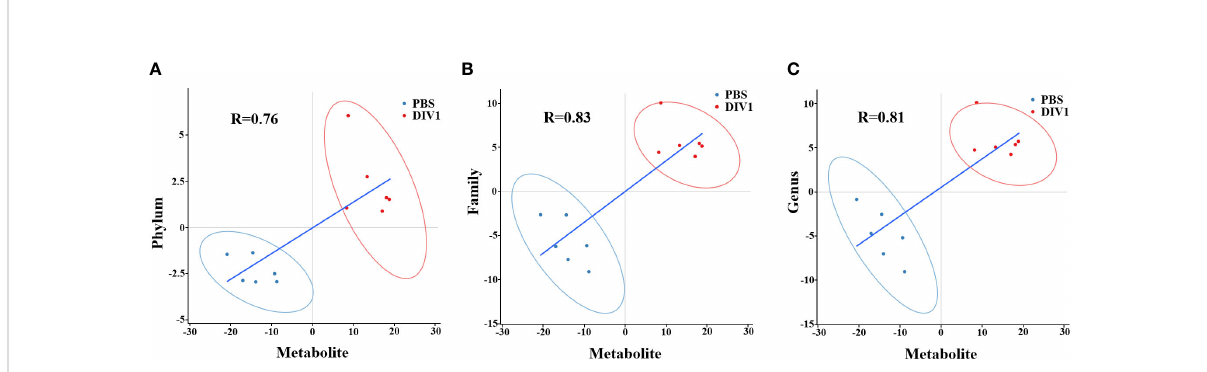
FIGURE 9 Scatter plots of correlation between DMs and hosts intestinal microbial. (A) Phylum classi fi cation level. (B) Family classi fi cation level. (C) Genus classi fi cation